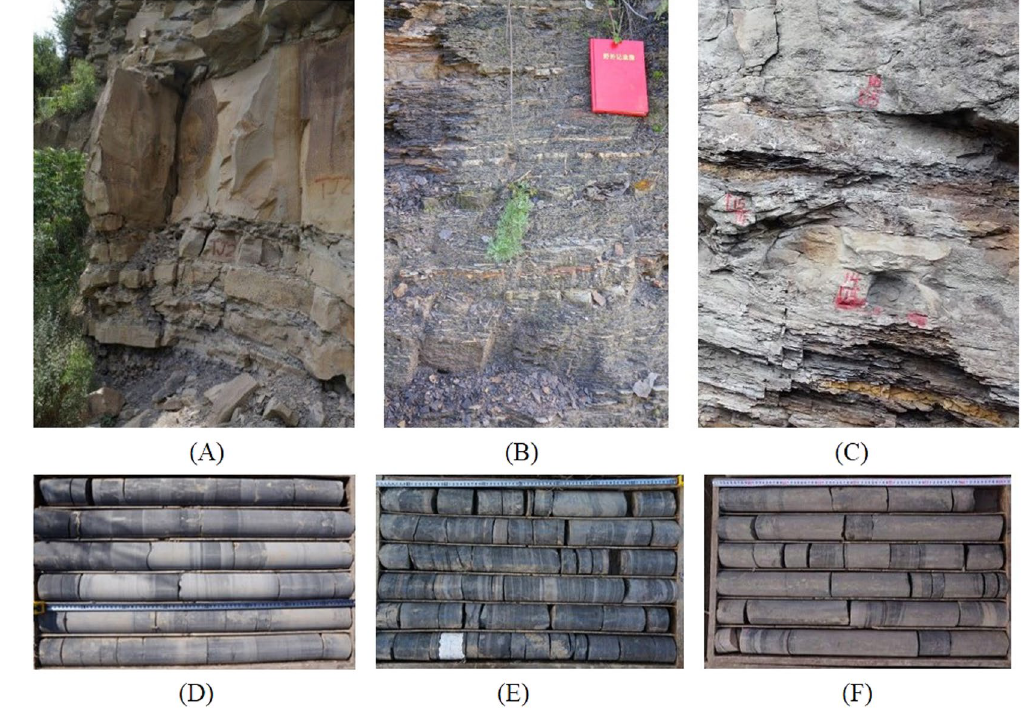
Figure 7. Lithology characteristics of the Chang 7 Member (Yanchang Formation of the Ordos Basin). ( A ) Outcrop of the Chang 71 Member, thick or medium thin sandstone interbedded with thin oil shale. ( B ) Outcrop of the Chang 72 Member, thin oil shale interbedded with thin tuff and sandstone. ( C ) Outcrop of the Chang 73 Member, thick tuff interbedded with thin oil shale and sandstone. ( D ) Core photograph of the Chang 71 Member. ( E ) Core photograph of the Chang 72 Member. ( F ) Core photograph of the Chang 73 Member. The core photographs in this figure were taken in well YK01. The photographs of the outcrops in this figure were taken in Yaoqu County, near well YK01. All of these photographs were taken by the corresponding author.